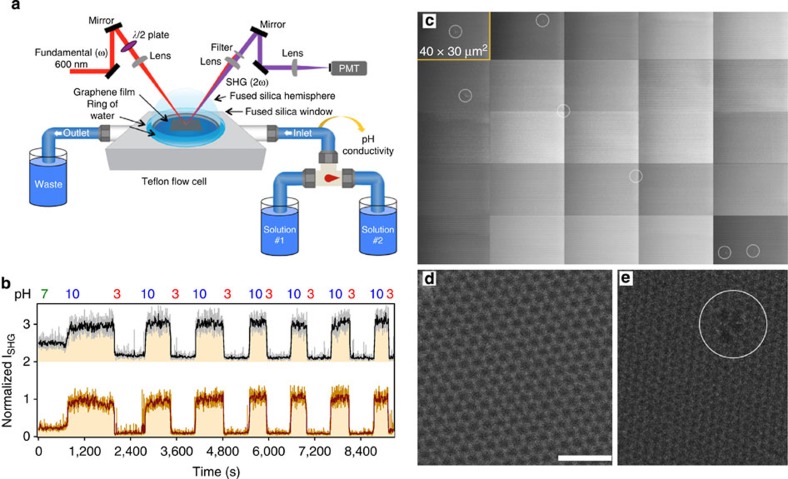
Experimental approach.(a) Experimental setup using a waveplate (λ/2) to prepare 600 nm light plane-polarized parallel to the plane of incidence (p-in) while a photomultiplier tube (PMT) detects the SHG photons at λ=300 nm. (b) p-in/all-out polarized SHG response recorded as a function of time from the fused silica/water interface during pH jumps from 7 to 3 to 10 and subsequent pH cycling between 3 and 10 at a bulk aqueous flow of 0.9 ml/s and 1 mM NaCl concentration in the absence (crimson, bottom) and presence (black, top, offset for clarity) of single-layer graphene placed between the fused silica substrate and the flowing bulk aqueous phase. Five-point boxcar indicated by dark lines. (c) Composite of 25 SEM images of single-layer graphene on a fused silica substrate, showing seven macroscopic pinholes, marked by white circles. (d) High-resolution aberration-corrected ADF STEM images of defect-free single-layer graphene on a transmission electron microscopy grid and (e) of a rarely imaged atomic defect. Scale, 1 nm.